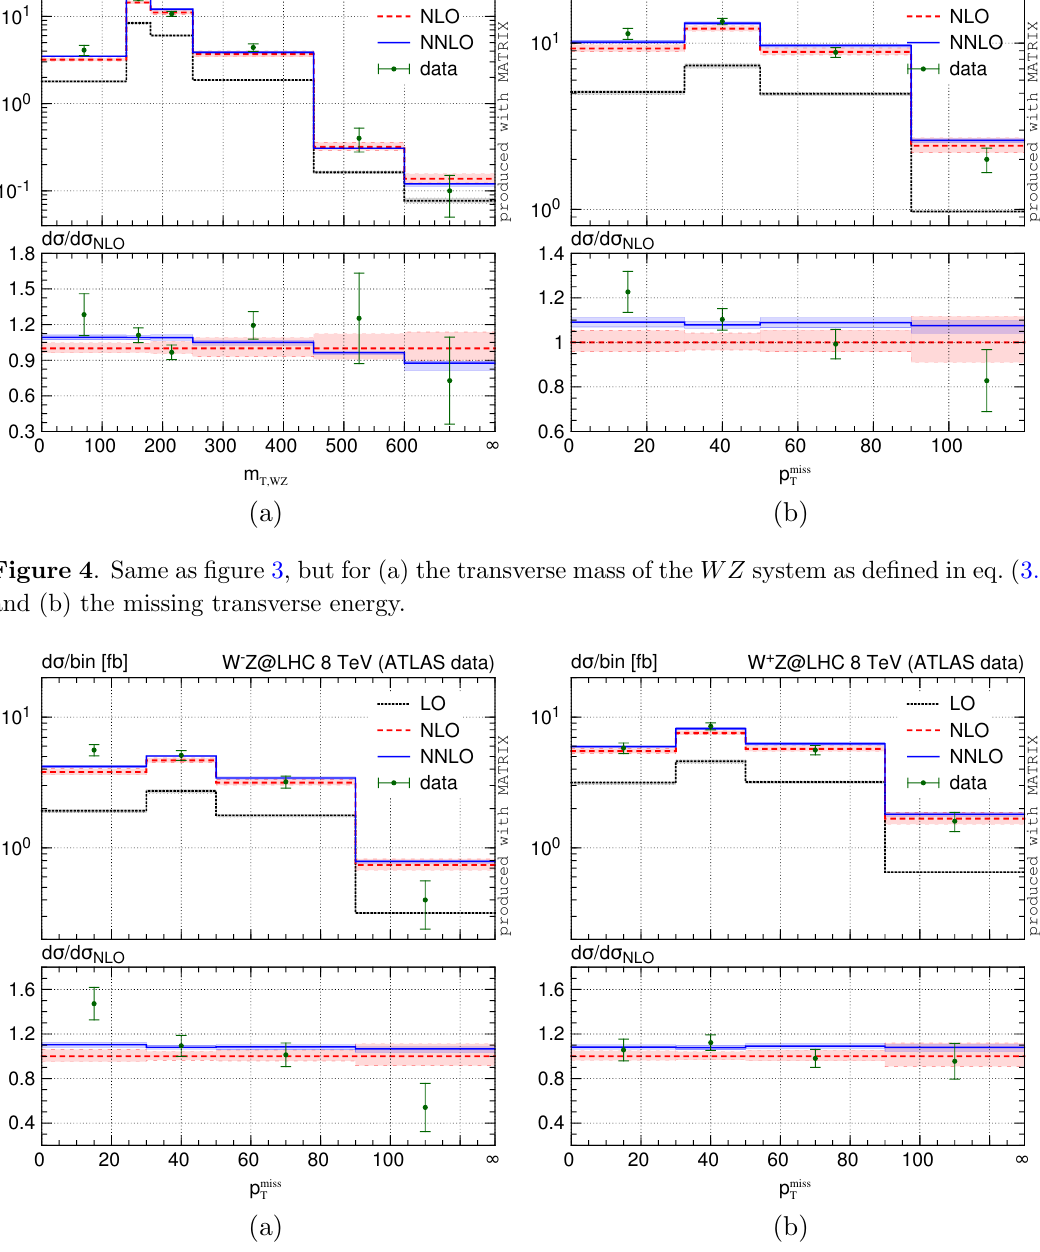
Figure 5 . Same as (cid:12)gure 4 (b), but separated by (a) W (cid:0) Z and (b) W + Z